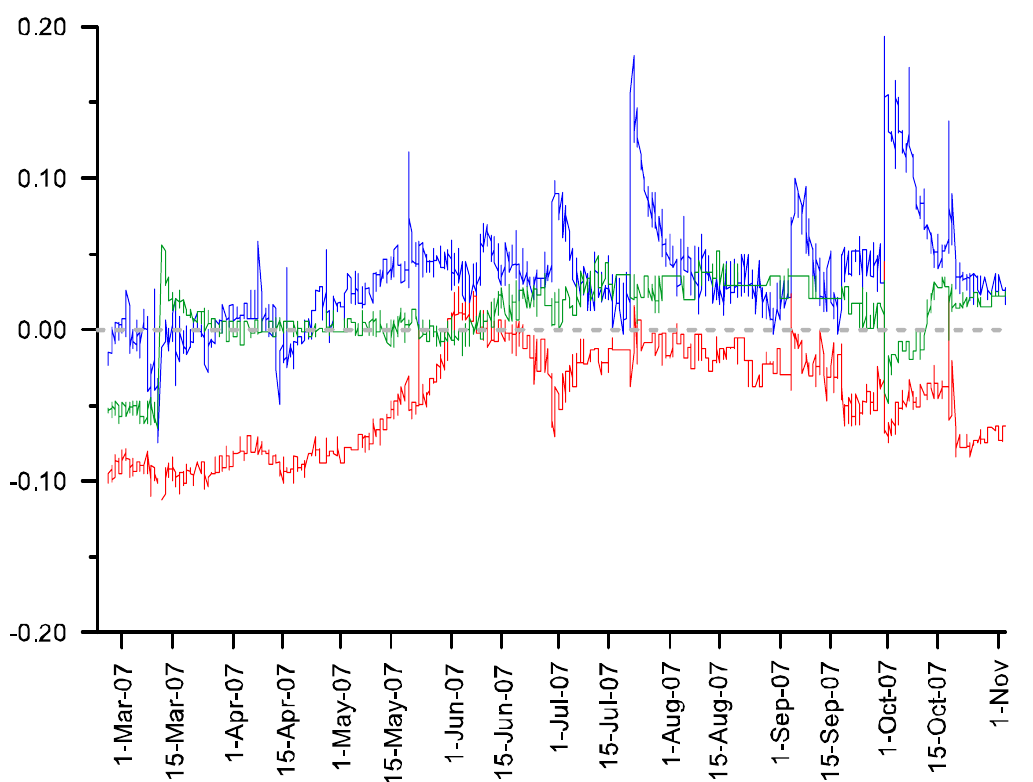
Figure 3. Differences in soil moisture between Plots 14 (control) and 15 (treatment) over time. The soil moisture probe depths are 5 cm (blue), 20 cm (red), and 50 cm (green). Positive values indicate that soil moisture is higher in presence of exotic vegetation.